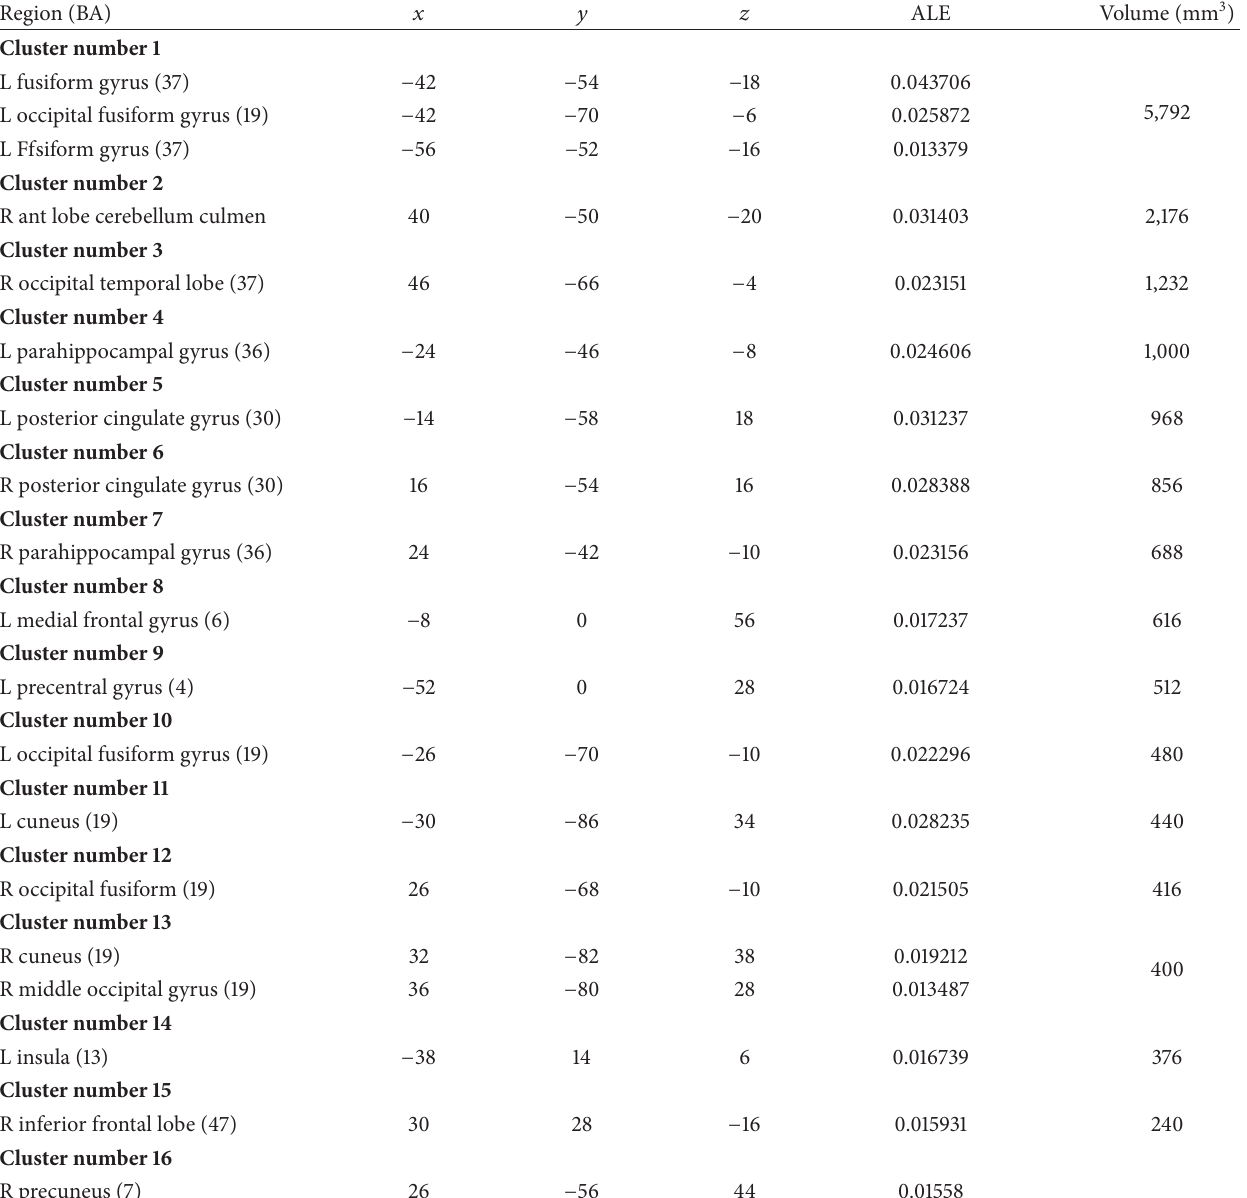
Table 4: Main loci of brain connectivity of BA37 in visual perceptual tasks by meta-analytic connectivity modeling